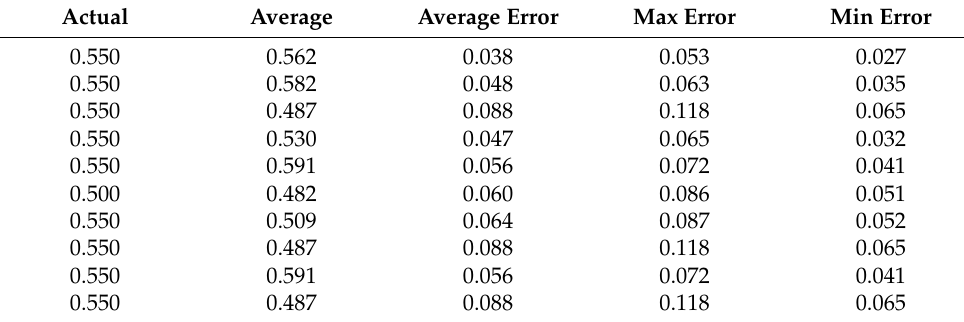
Table A143. Set 2, trials 41–50 data (all 0.5 PR values).